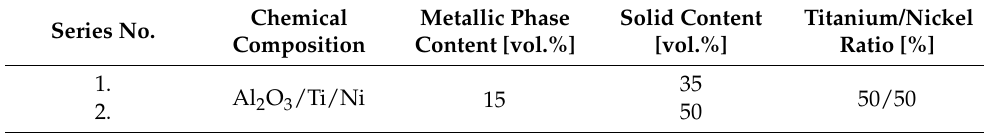
Table 1. Characteristics of the composite series. Series